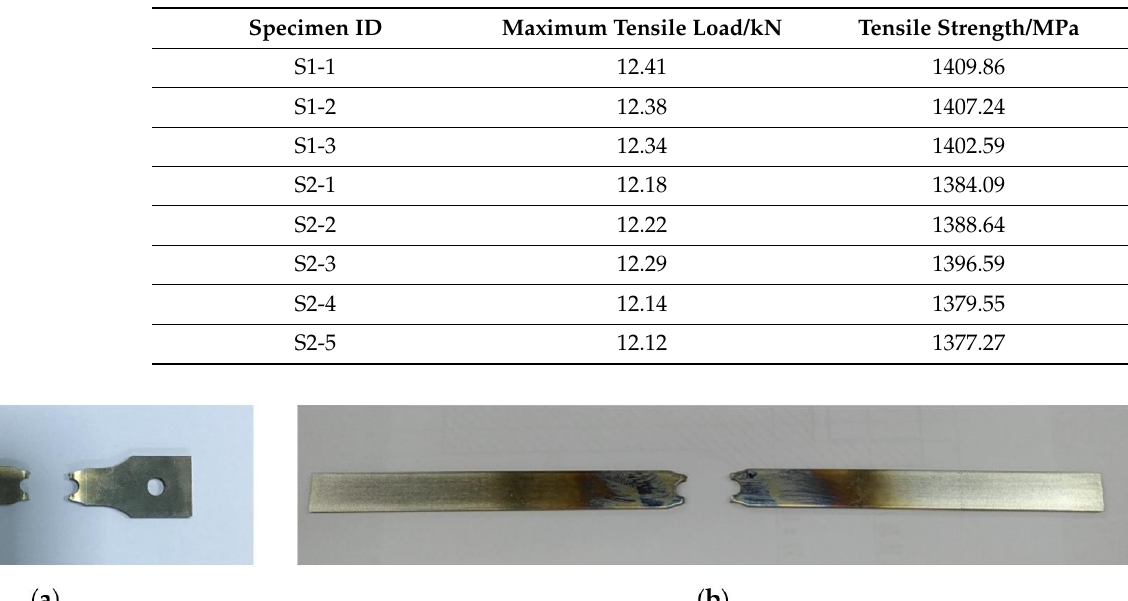
Figure 18. Simulative specimen with different clamping methods: ( a ) Clamped by pin holes; ( b ) Clamped by hydraulic pressure. Table 3. The test data.